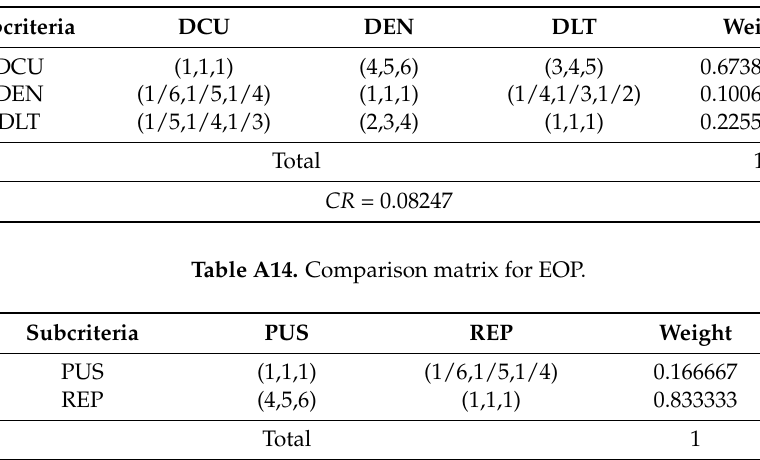
Table A13. Comparison matrix for SWQ.